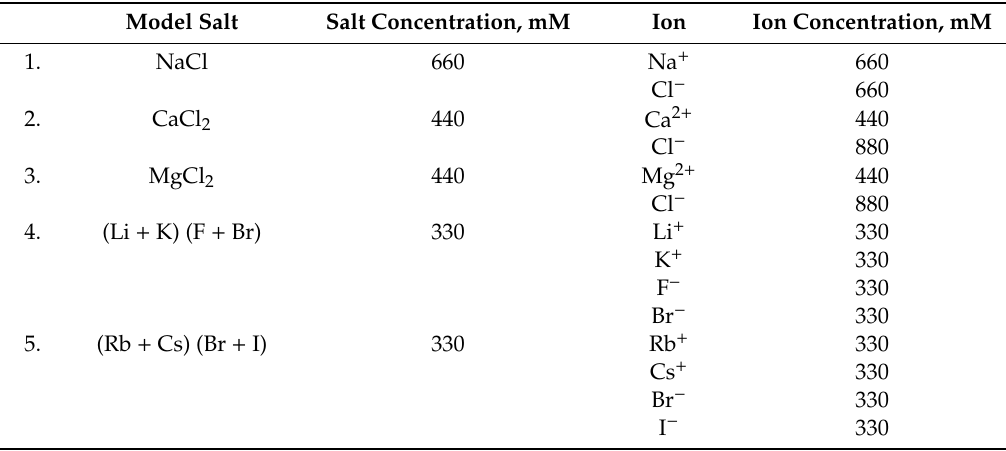
Table 2. Initial concentrations of ions in the feeder